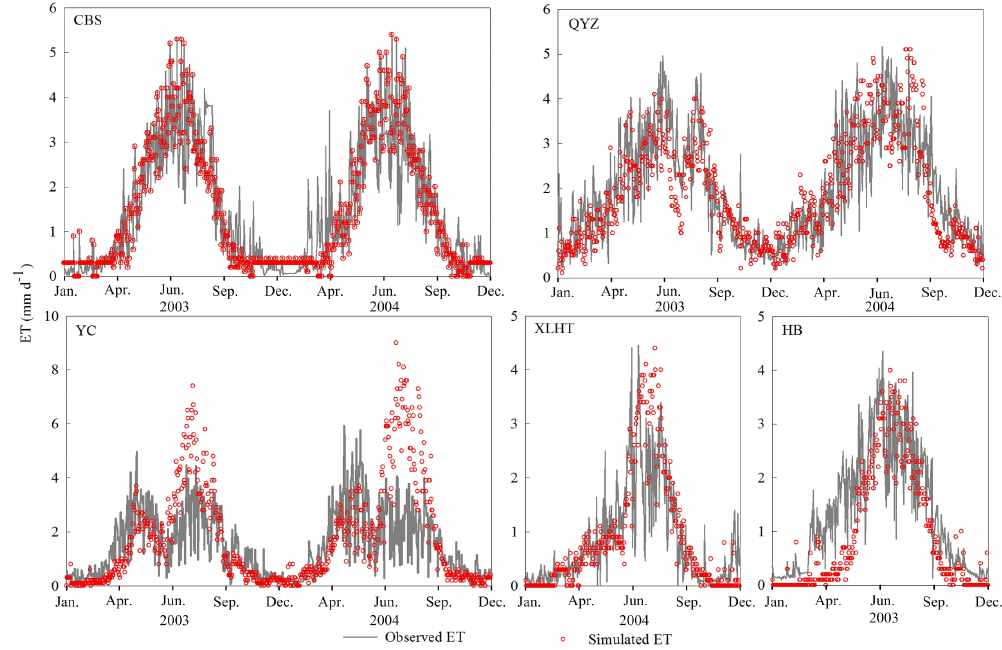
Fig. 3. Time series of observed and simulated daily ET (mmd − 1 ) from 2003 to 2005 at CBS, QYZ, YC, from 2004 to 2005 at XLHT, and from 2003 to 2004 at HB. Site information is stated in Table 2.